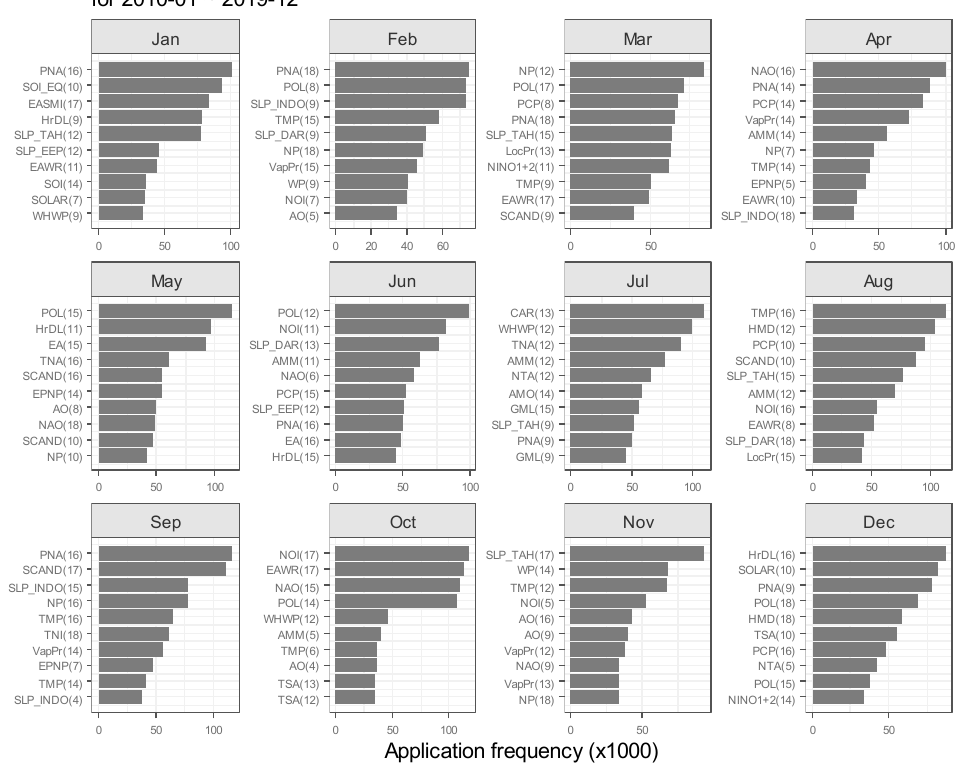
Figure 8. Monthly climate index application frequency for the entire analytical period (2010–2019).